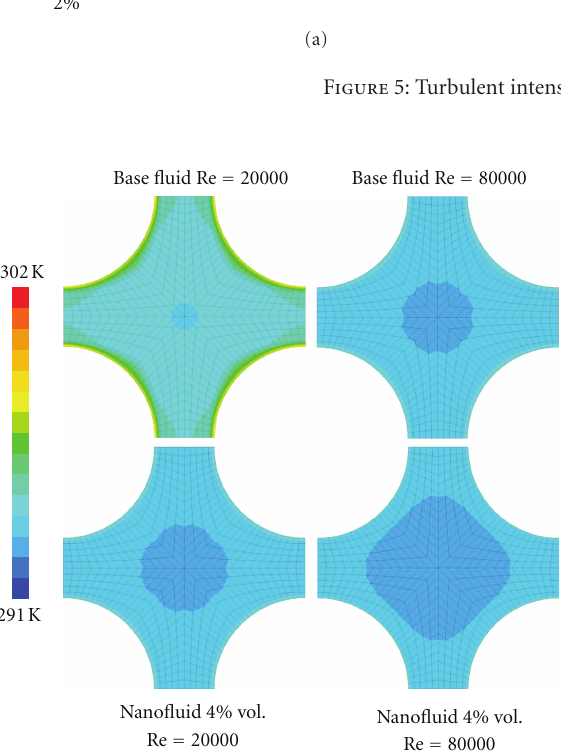
Figure 7: Coolant temperature distribution along centerline of channel for di ff erent volume concentration of nanofluids for Re = 80 × 10 3